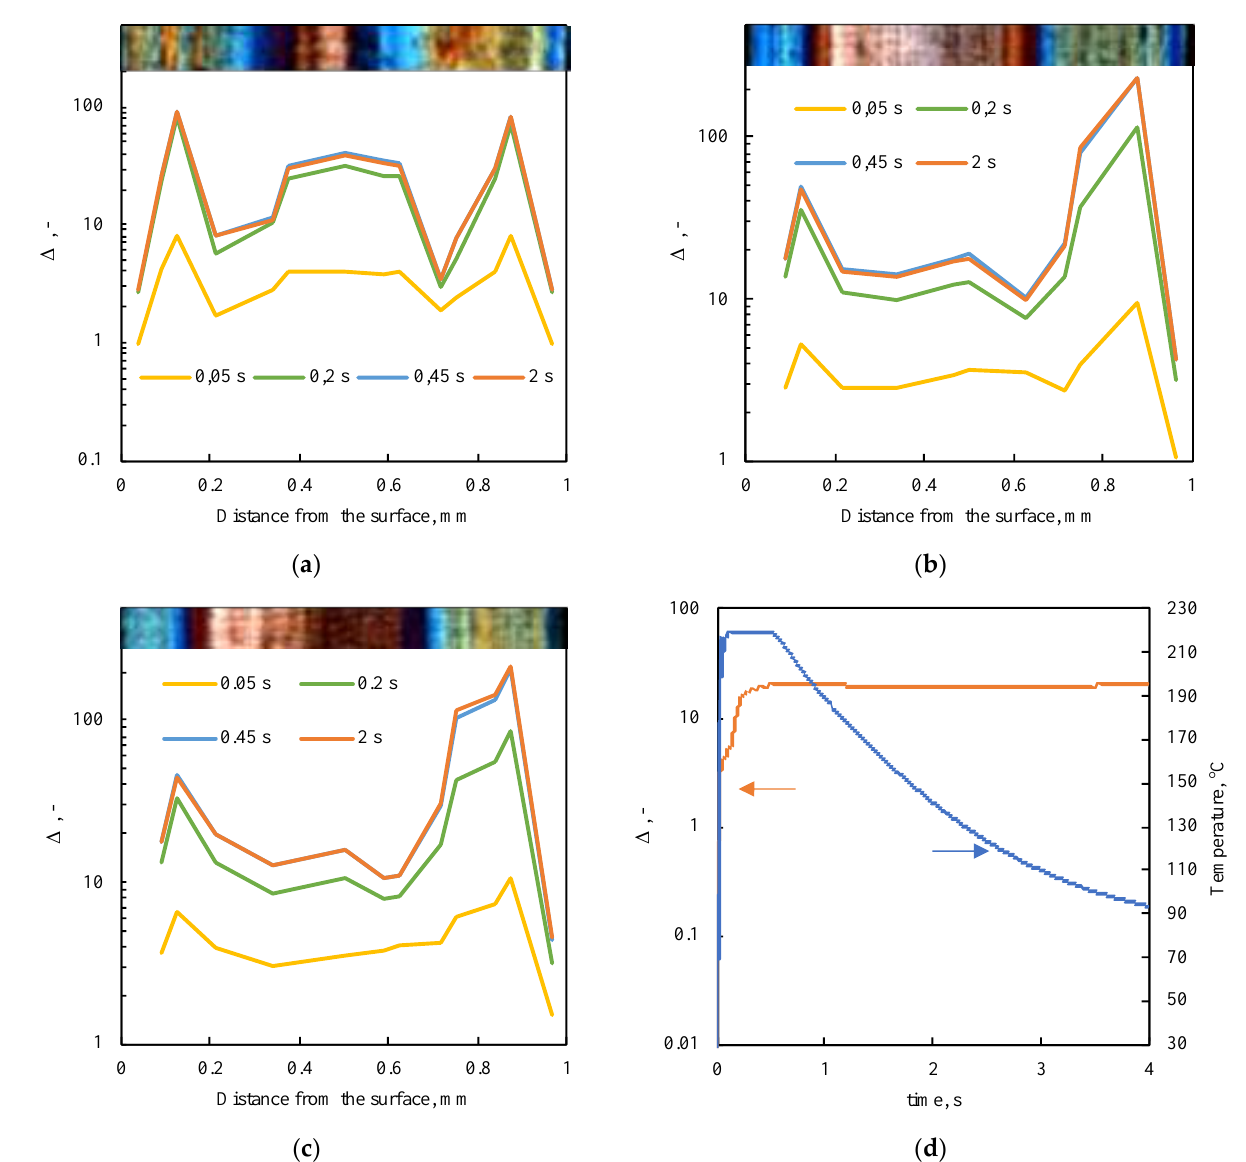
Figure 8. Temperature distribution along the cavity thickness for the ( a ) conventional injection molding case, ( b ) 40 W heating power, and ( c ) 68 W heating power. ( d ) Evolutions of temperature and molecular orientation for the case with a 68 W heating power at 0.214 mm from the heated side.